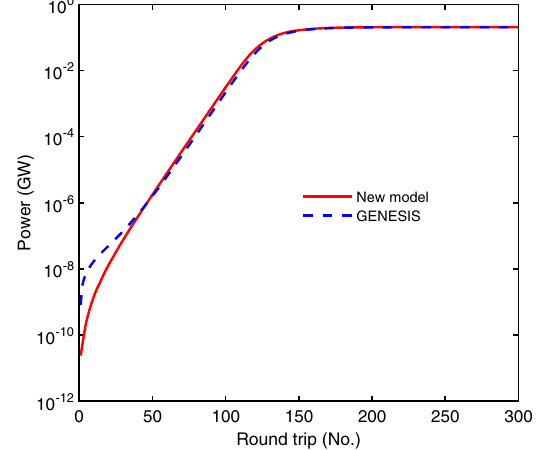
FIG. 4. The enhancement of output laser peak power with various passes N . pass